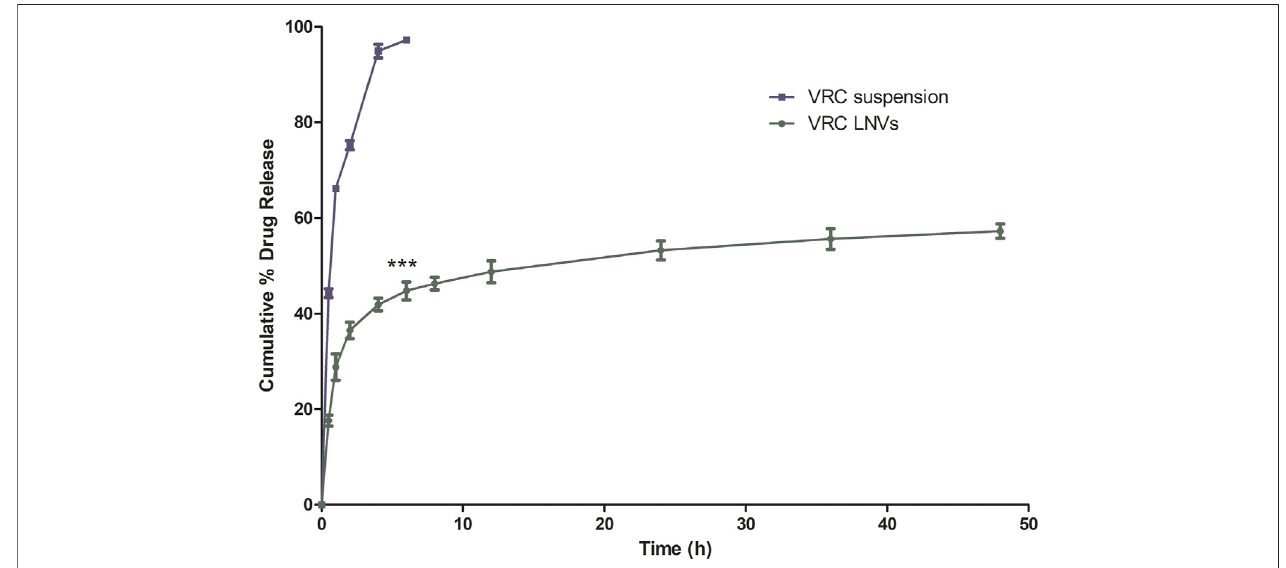
FIGURE 3 | In vitro cumulative drug release pro fi le of voriconazole (VRC) suspension and optimized lipid nanovesicles (LNVs) in 20 ml phosphate buffer saline pH 7.4 for a time period of 48 h. Error bars represents Mean ± SD values ( n (cid:2) 3). The asterisks represent statistically signi fi cant difference (*** p < 0.0001) between the drug release pro fi le of VRC from suspension and of LNVs at the same time period, i.e., of 6 h.